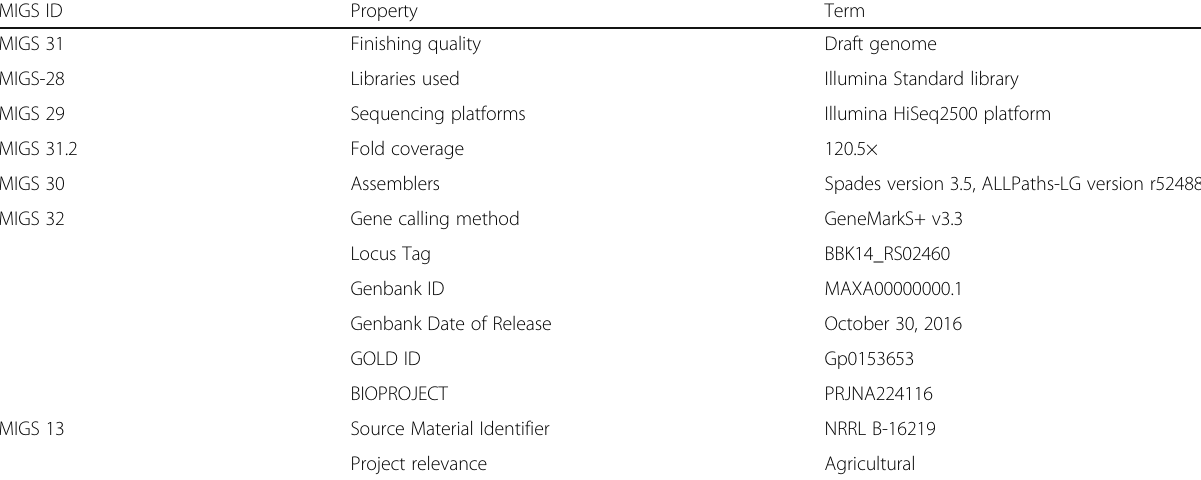
Table 2 Project information